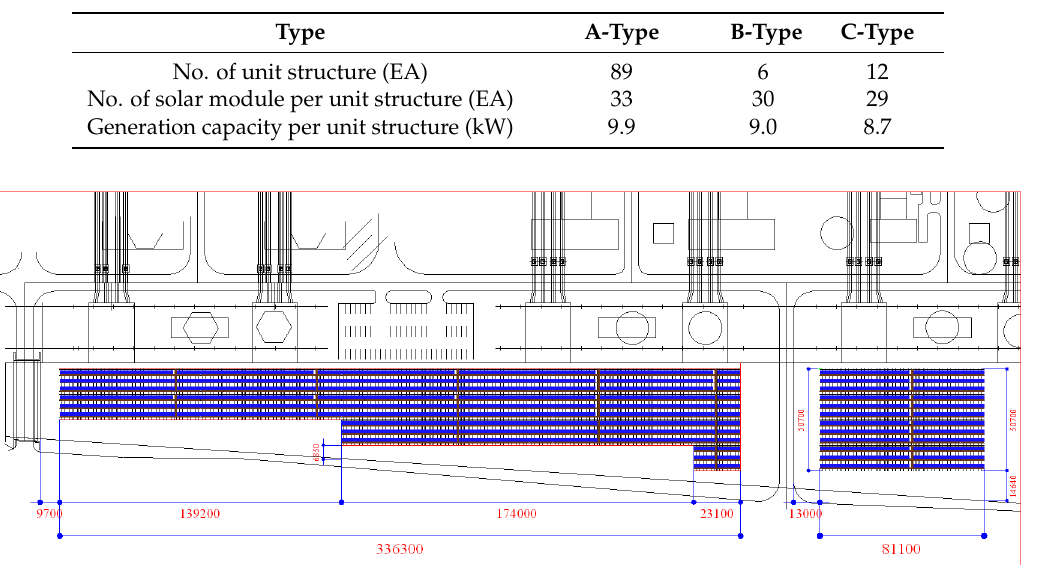
Table 1. No. and generation capacity of each unit structure.